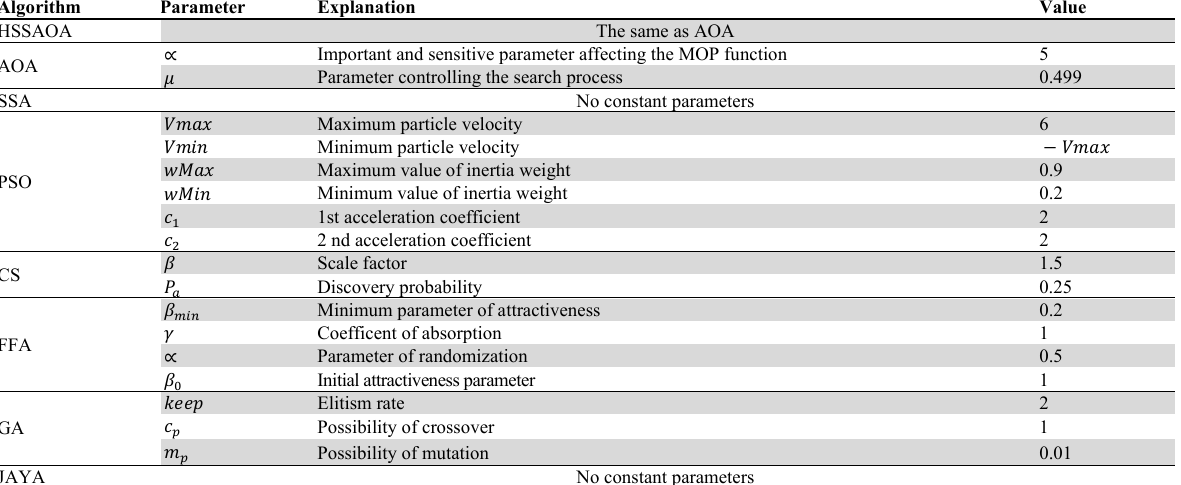
Parameters, explanations and values of HSSAOA and other algorithms Algorithm